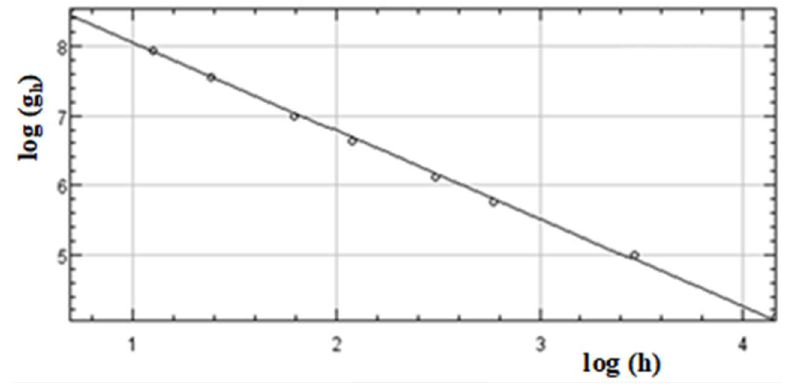
Figure 6. Relationship between the log(g h ) and the unit cell length, h, for the micro-/nano-texture in Figure 4, after the box-counting method.